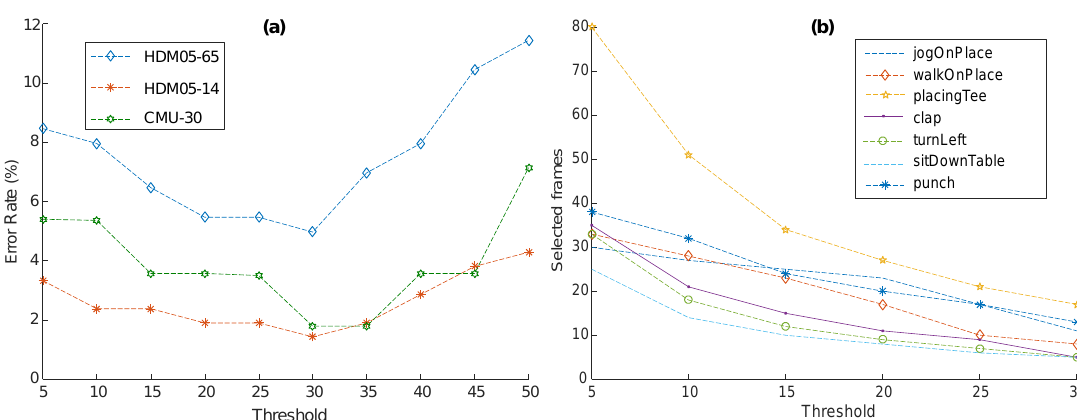
Figure 3. ( a ) Threshold tuning on different datasets. ( b ) The number of keyframes extracted through different threshold values for a variety of motions.